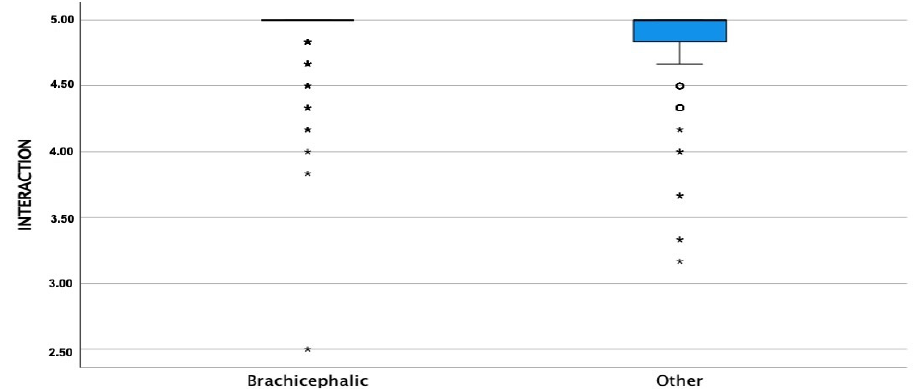
Figure 1. Comparison of cat-owner interaction subscale (COI) means between brachycephalic and non-brachycephalic breeds. Dots represent weak outliers; stars represent strong outliers.